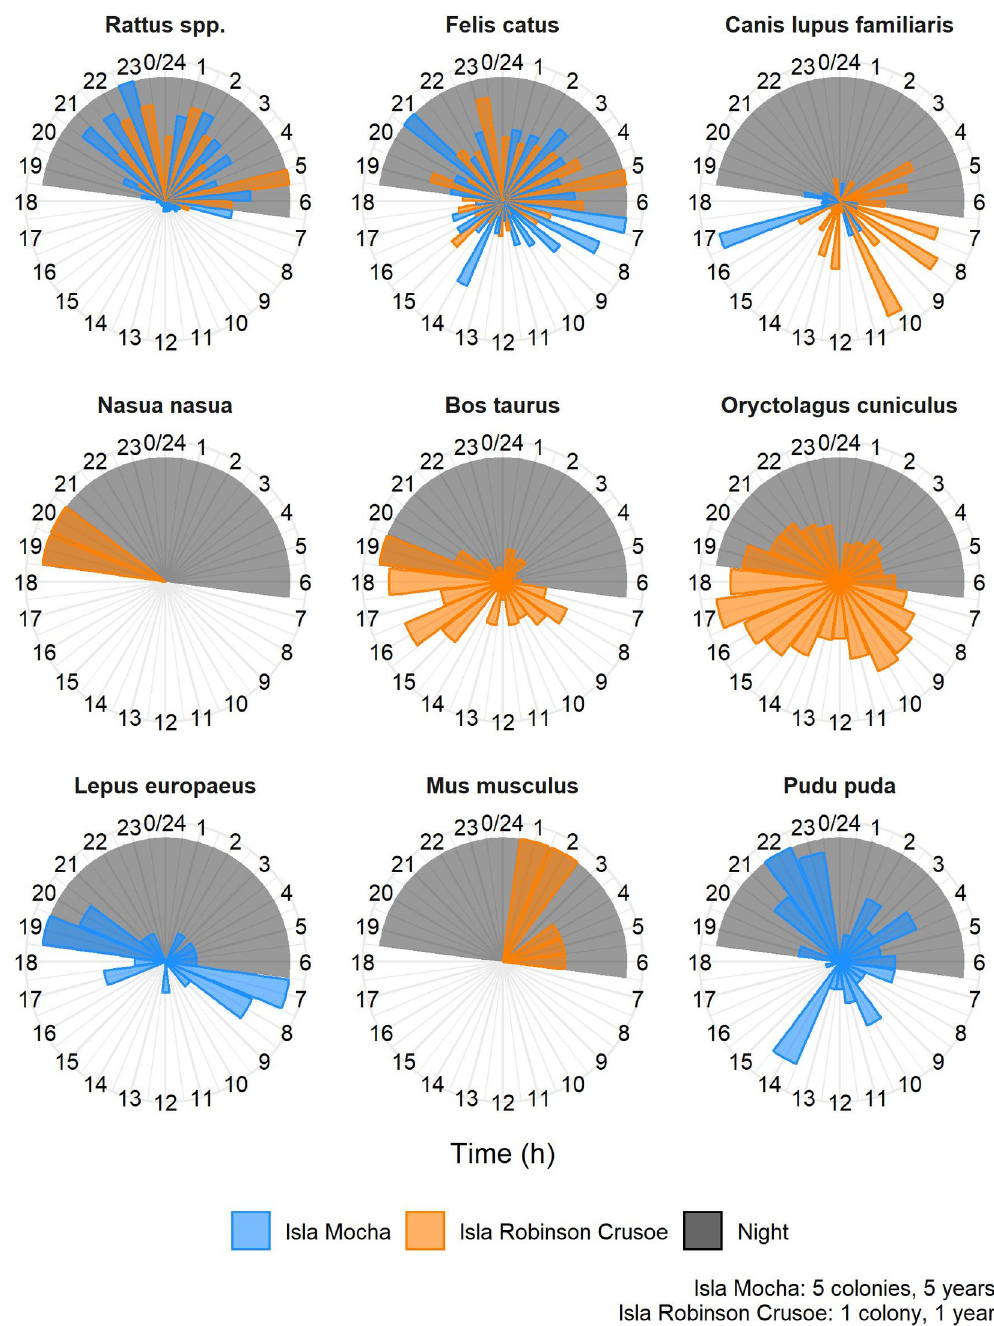
Fig 5. Diel island-specific attendance of mammals in pink-footed shearwaters colonies on Isla Mocha (inside circle, blue; five colonies, 2015–2020) and Isla Robinson Crusoe (outside circle, orange; one colony, 2019–2020), Chile. Proportion of island-specific maximum CPUE was calculated by dividing each species’ hourly CPUE by the maximum recorded hourly CPUE for that species on each island, and averaging the results for each hour of the day. This unitless relative CPUE metric can be used to compare diel attendance across islands, but does not reflect actual magnitude or relative abundance of species because the maximum CPUEs were species- and island-specific. Bay size indicates the proportion of the island-specific maximum CPUE for each day on each island. The longest bar represents the highest CPUE for that species on that island. All mammals shown were introduced with the exception of the pudu´ (Pudu pada), whose native status was